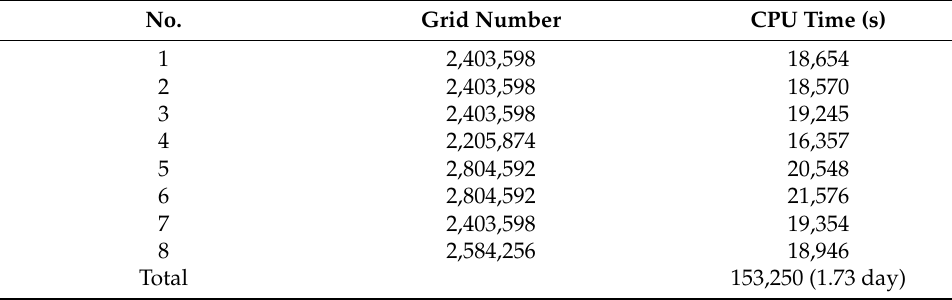
Table 2. CPU time cost of CFD simulations.